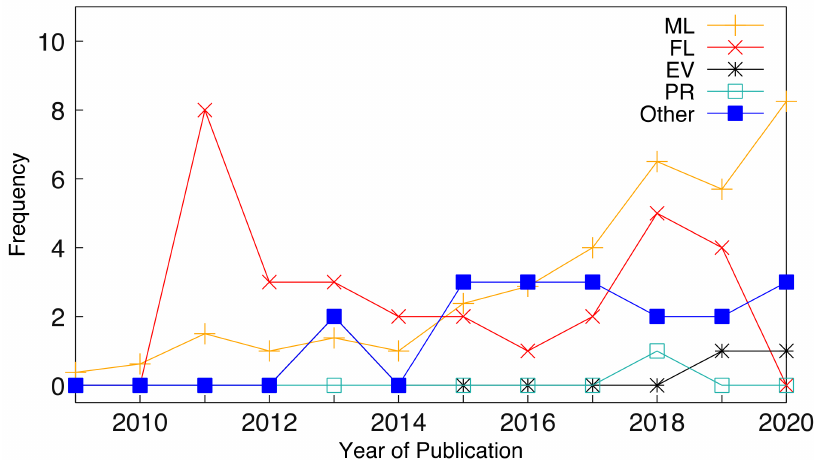
Figure 4. The frequency of soft computing techniques covered by all studies.